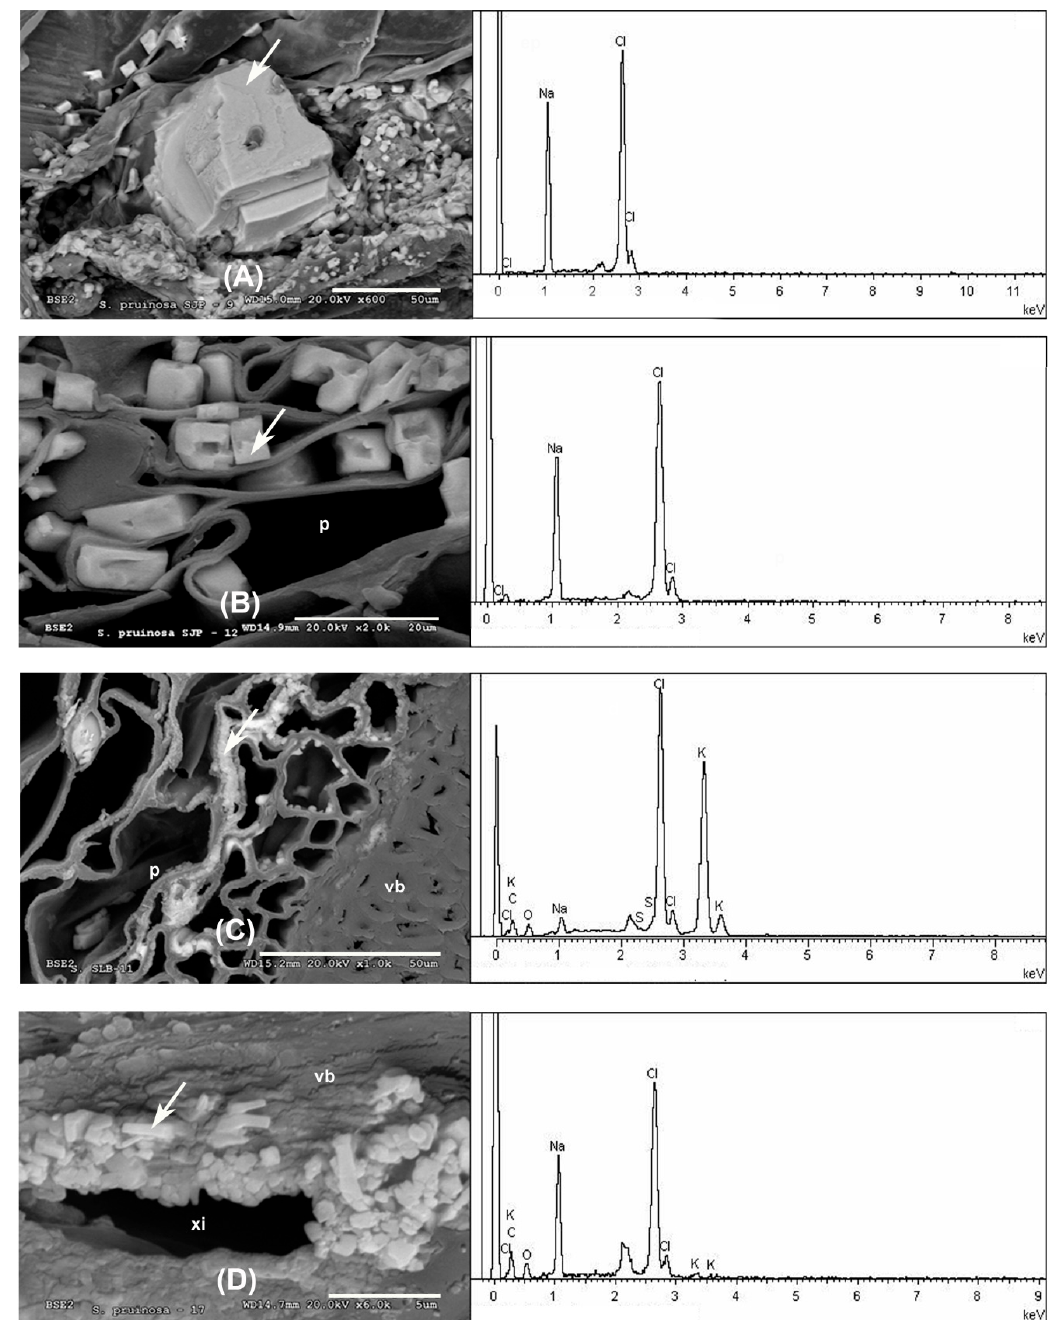
Figure 3. Representative SEM images of Na and K biominerals in S. pruinosa . ( A ) Details of NaCl crystals in the epidermis. ( B ) Major salts of NaCl in parenchyma of transverse section of stem. ( C ) Detail of KCl salts in the parenchyma. ( D ) Xylem of floriferous stem collapsed by crystals of K, Cl and Na. EDX spectra to the right of each section corresponds to the analyzed spot represented by the white arrow. Symbology: ep = epidermis; p = parenchyma; vb = vascular bundle; xi = xylem.